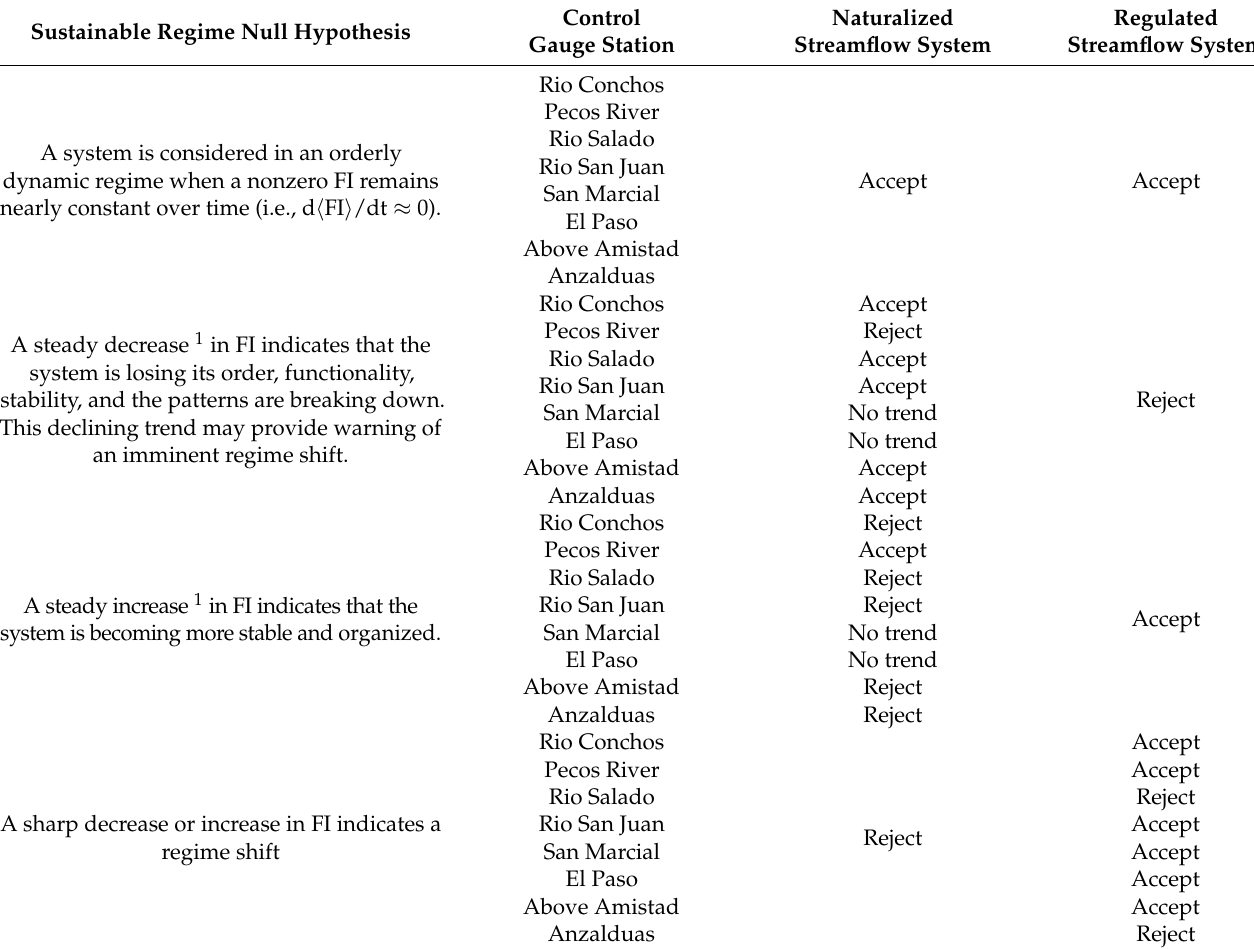
Table 2. Sustainable regime null hypothesis evaluation defined by the dynamics of the natural flow